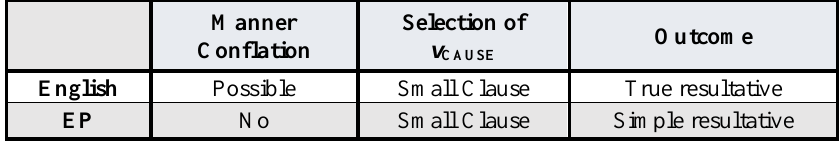
Table 1. Comparison of English-EP